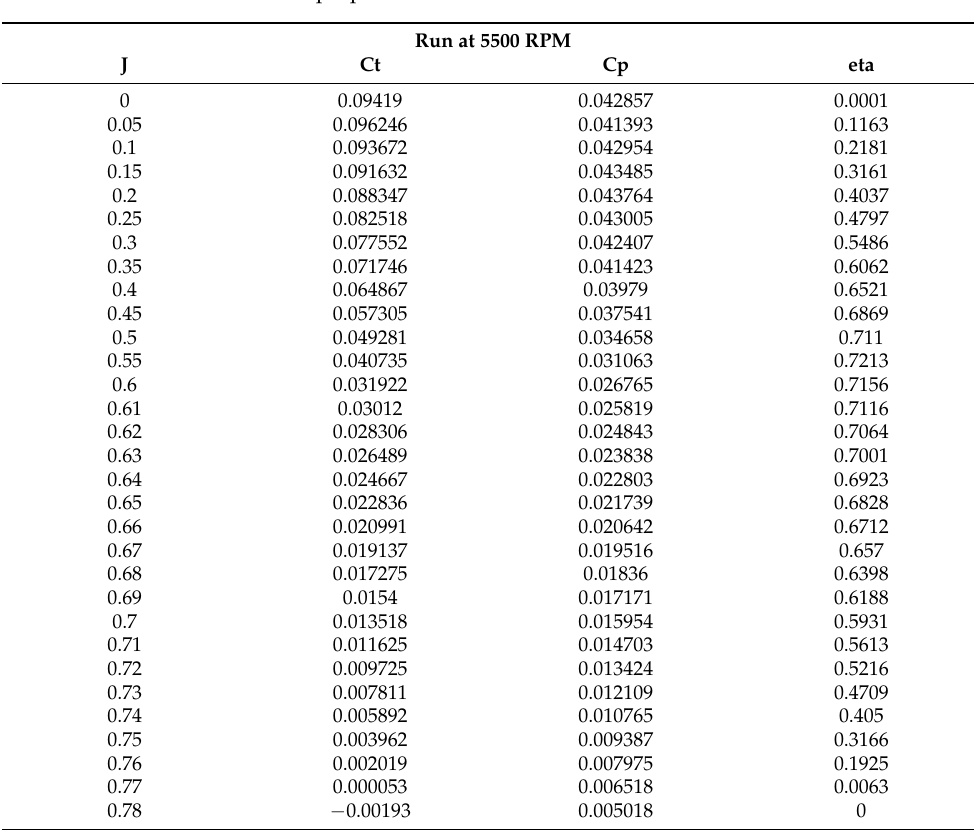
Table A27. BEMT 18 × 12 APC propeller data.